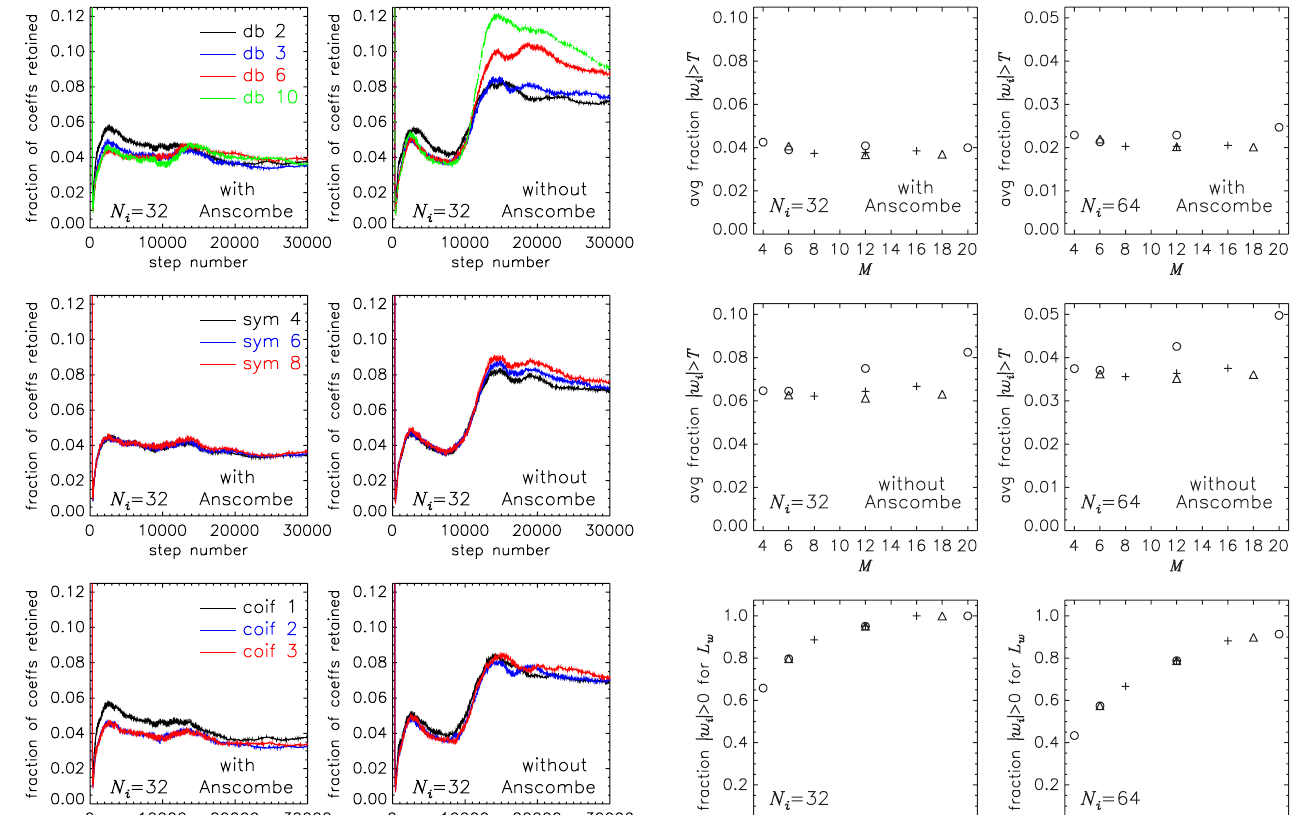
(cid:4) 64 ( N (cid:4) i